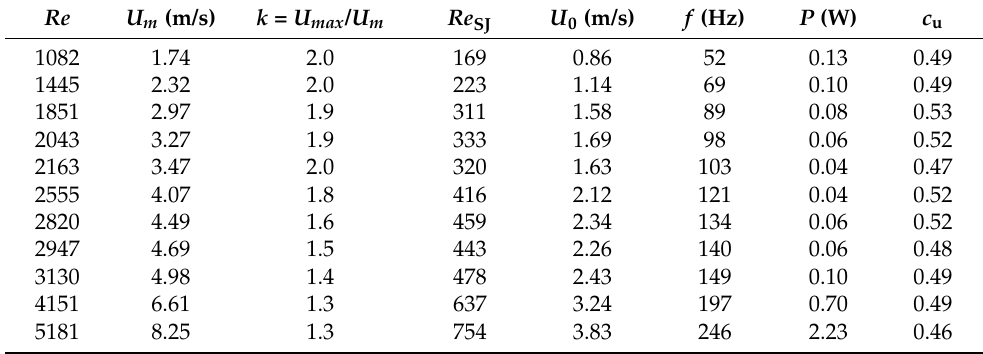
Table 1. Parameters of the